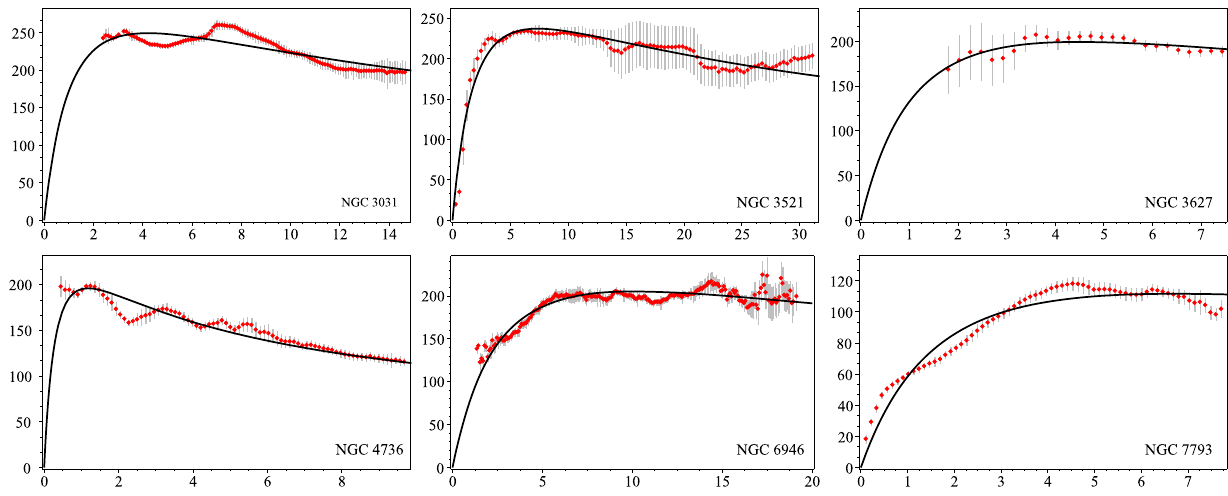
Fig. 2 (color online) Rotational velocities (in km/s) as a function of distance (in kpc). The black curve represents the best parametric fit of galaxy rotation curves using Eq. (32) for the sub-sample of six THINGS galaxies. The values of the best-fit parameters can be found in Table